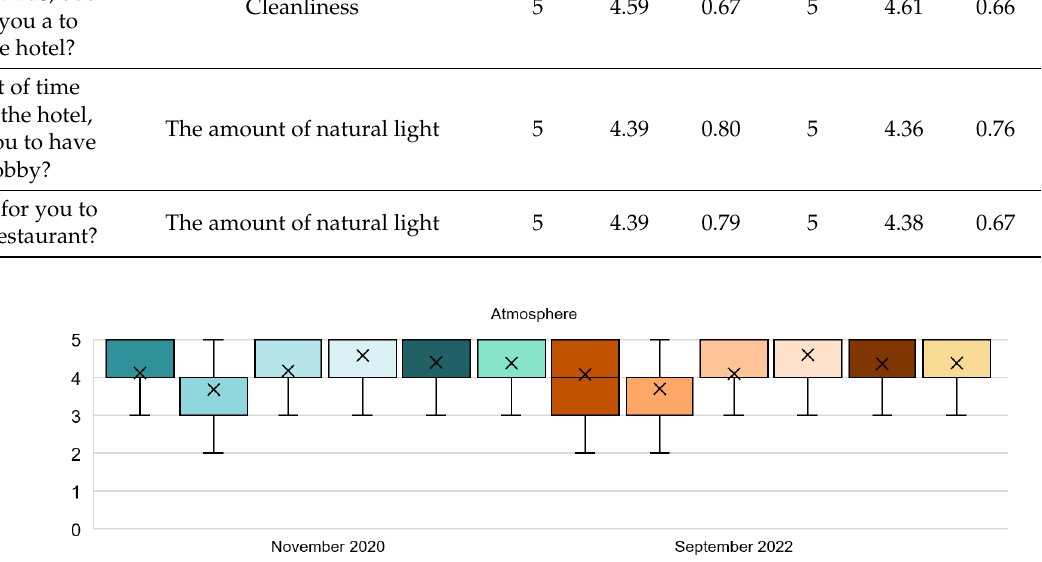
Table 4. Interval data analysis of the Atmosphere dimension.